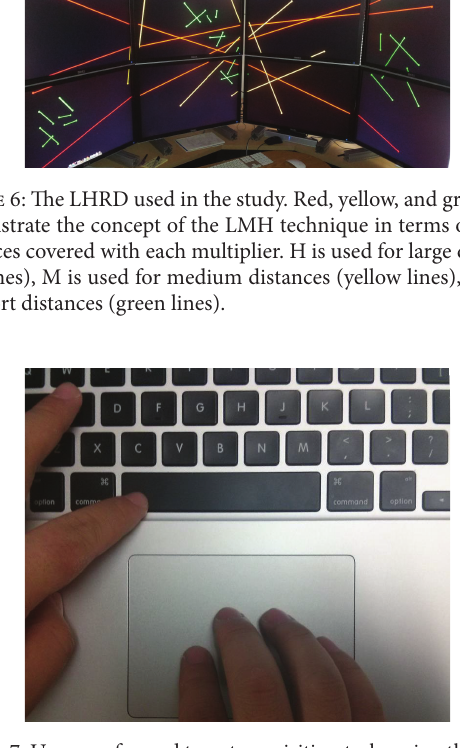
Figure 7: Users performed target acquisition tasks using the touch- pad on a MacBook Pro laptop. Users performed selections (clicks) using the space bar of the laptop with the other hand so as to avoid interference with the pointer movement